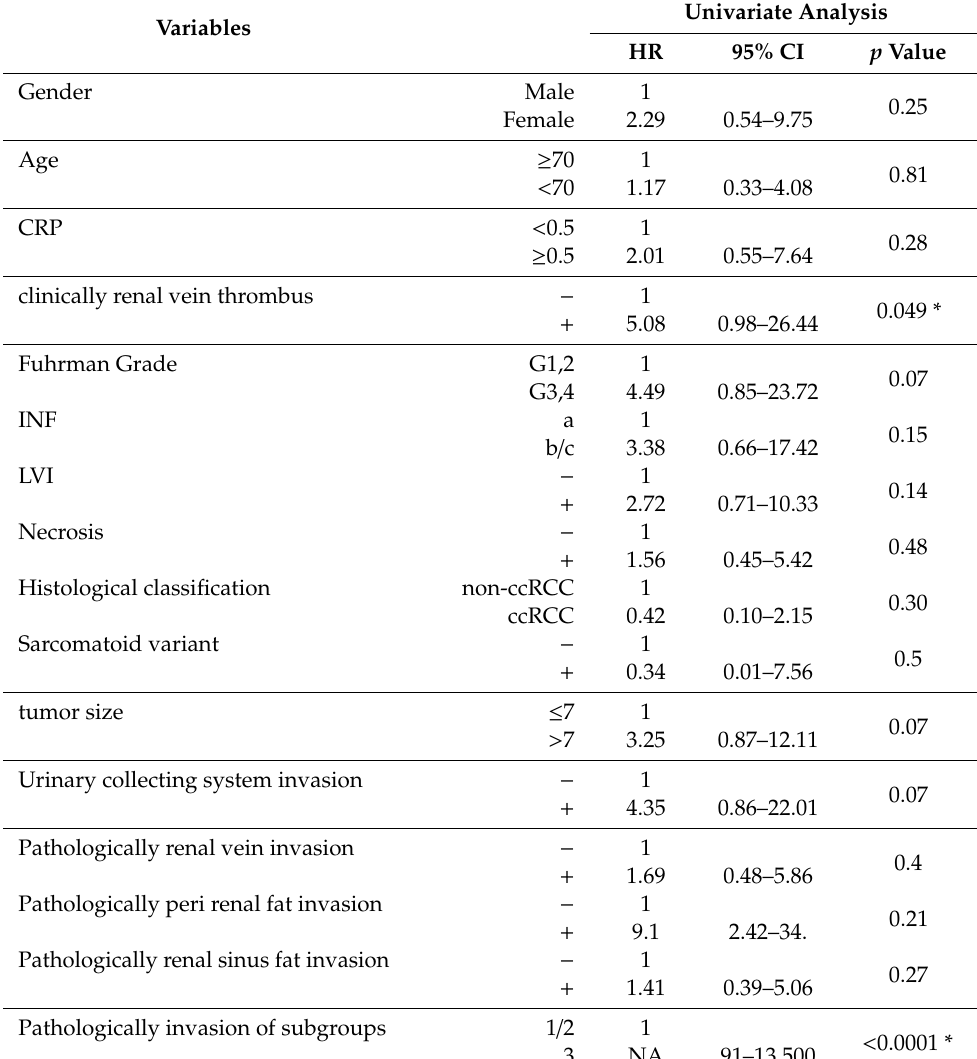
Table 3. Univariate analyses for CSS (* statistically